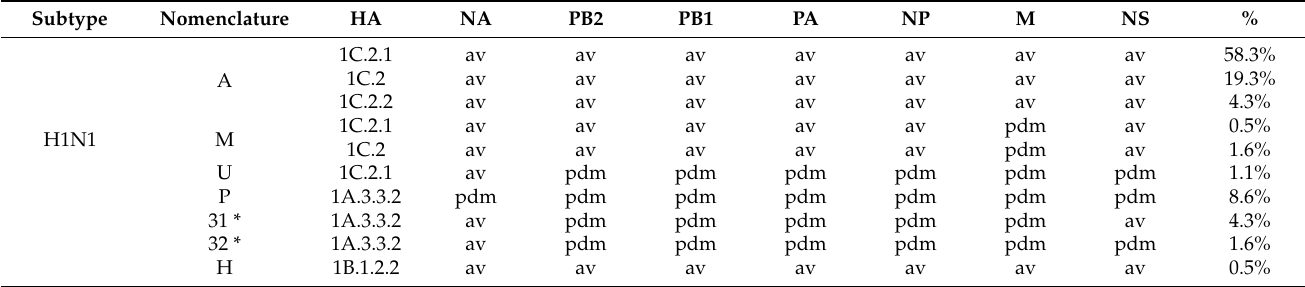
Table 4. List of H1N1 detected among 187 analyzed strains and relative percentages among